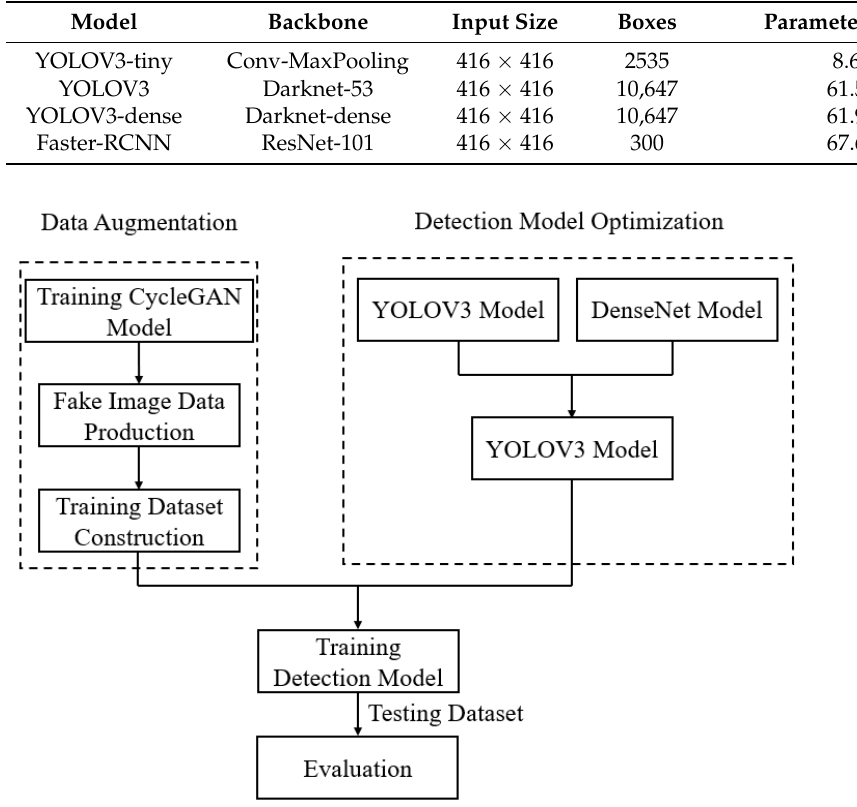
Table 1. The parameters of proposed model and other comparison models.